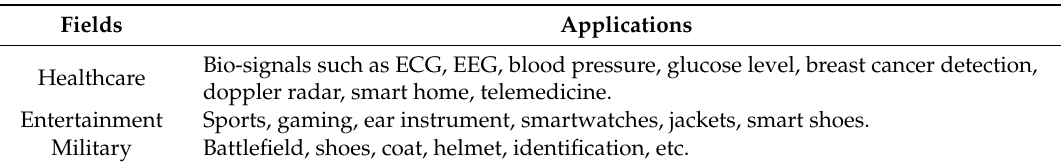
Table 1. Applications of wearable antennas